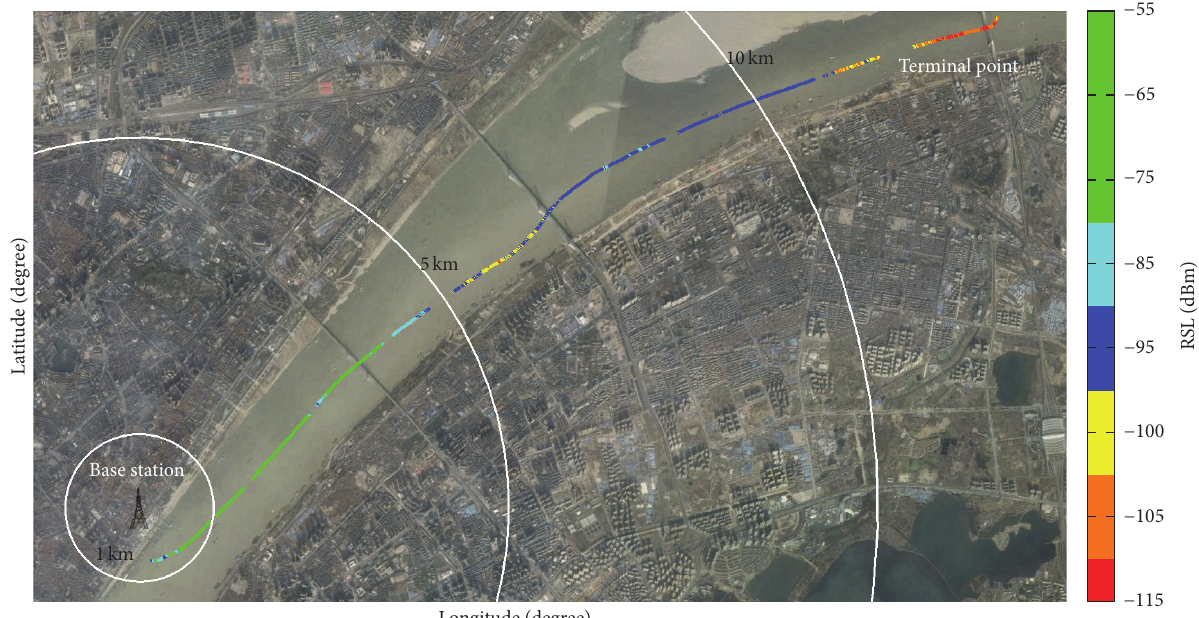
Figure 5: The route of measurement campaign 1 with few obstacles between TX and RX.